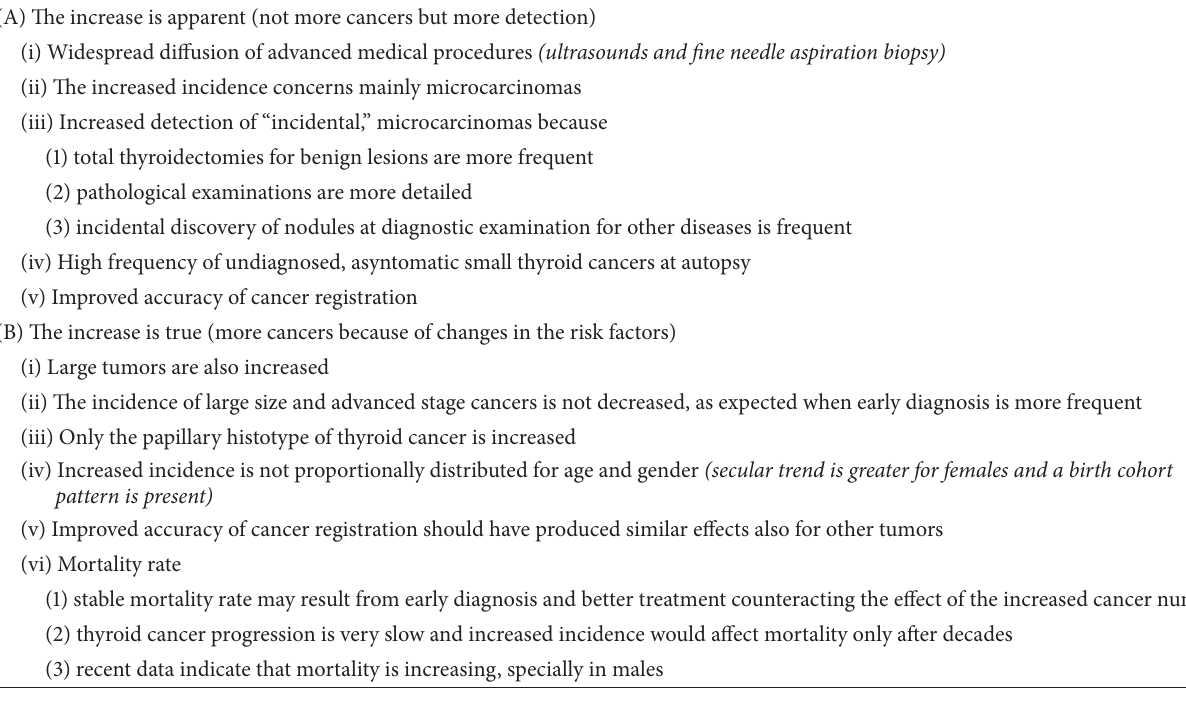
Table 2: Thyroid cancer incidence is increasing worldwide: possible reasons.